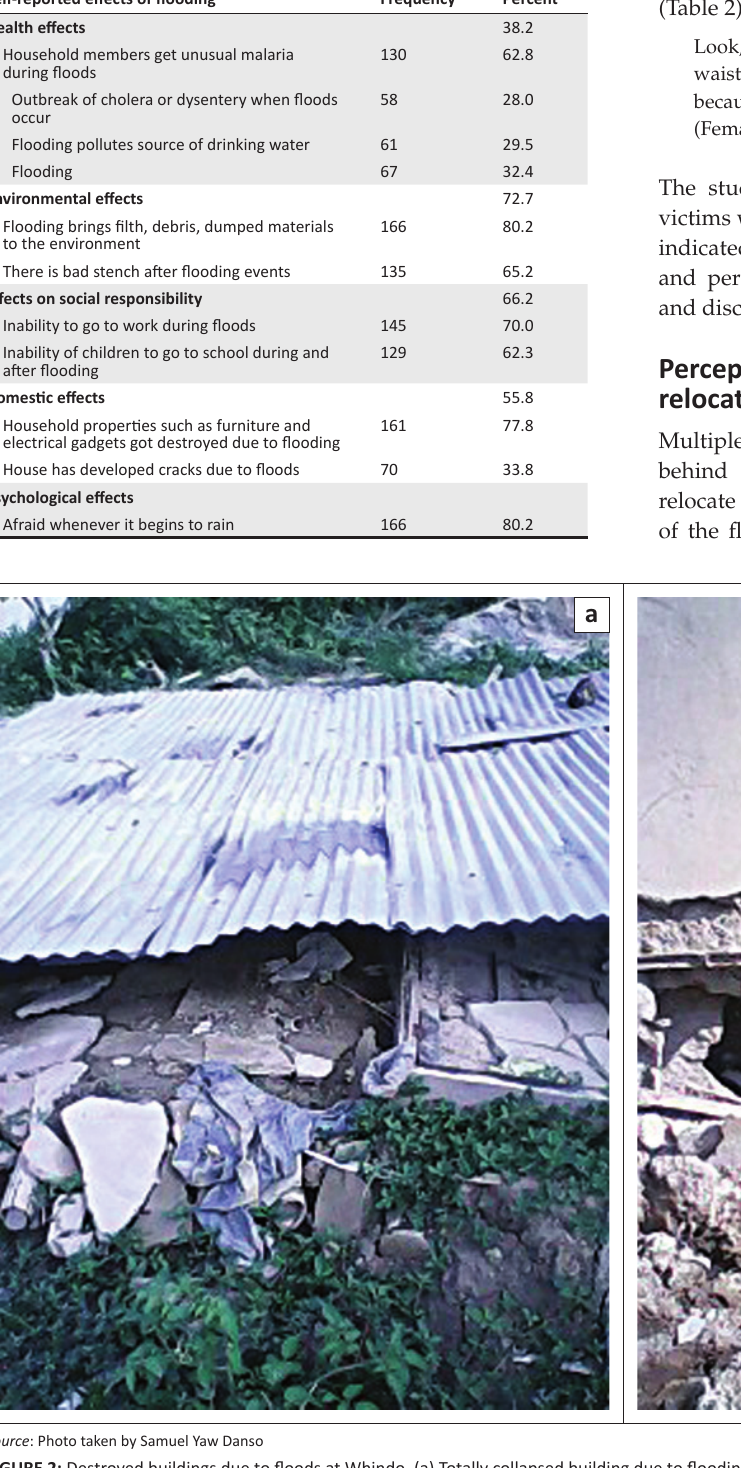
FIGURE 2: Destroyed buildings due to floods at Whindo. (a) Totally collapsed building due to flooding and (b) partially destroyed building due to